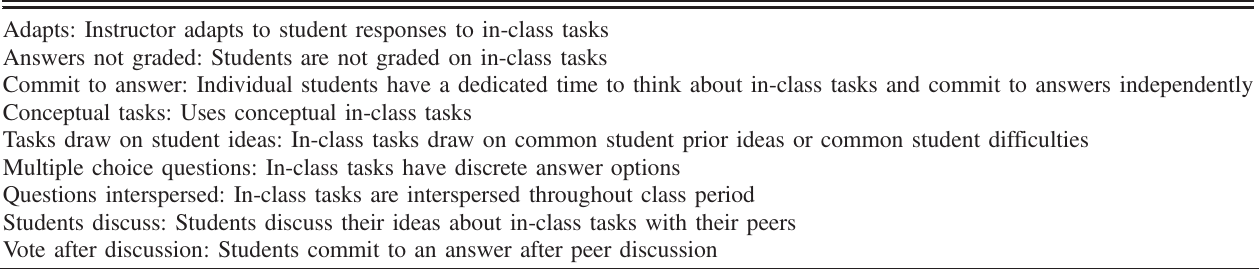
TABLE III. Nine features of Peer Instruction developed in consultation with Mazur. Adapts: Instructor adapts to student responses to in-class tasks Answers not graded: Students are not graded on in-class tasks Commit to answer: Individual students have a dedicated time to think about in-class tasks and commit to answers independently Conceptual tasks: Uses conceptual in-class tasks Tasks draw on student ideas: In-class tasks draw on common student prior ideas or common student difficulties Multiple choice questions: In-class tasks have discrete answer options Questions interspersed: In-class tasks are interspersed throughout class period Students discuss: Students discuss their ideas about in-class tasks with their peers Vote after discussion: Students commit to an answer after peer